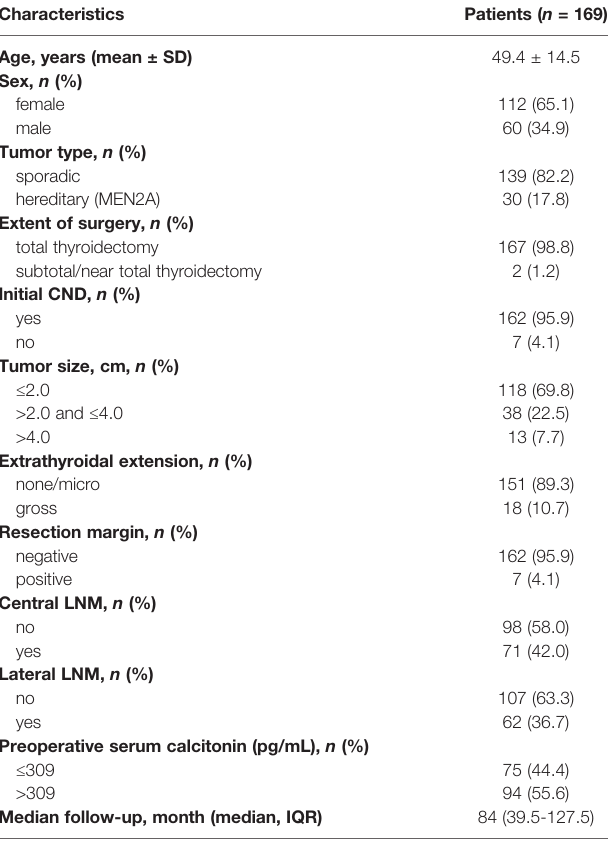
TABLE 1 | Baseline